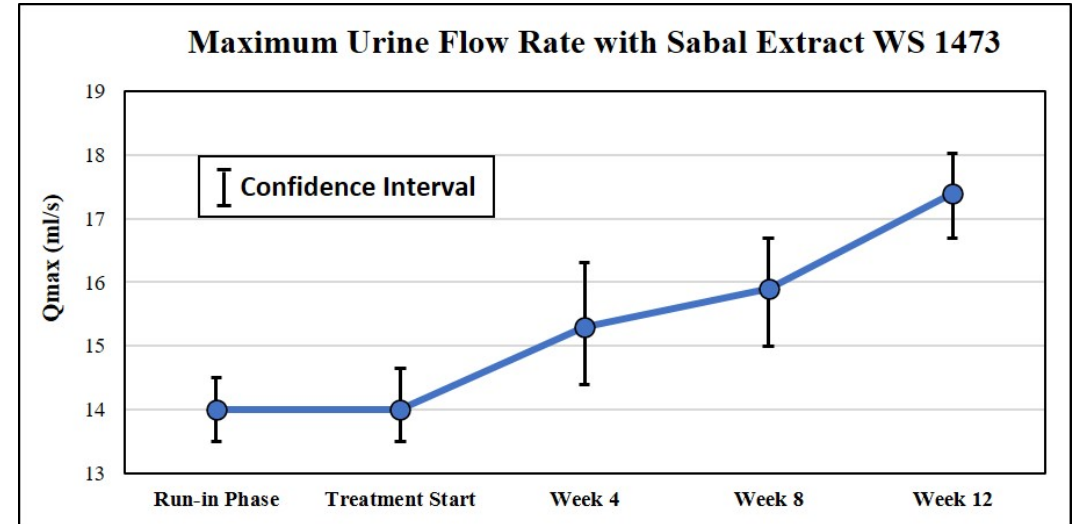
Figure 1. Data on maximum urine flow rate with the ethanolic extract of Serenoa repens (EESr) WS 1473 (Prostagutt Uno ® ) over a 12 wk study. Peak urinary flow rate (Q max , mL/s) mean value curve with a 95% confidence interval reported. Modified based on Redecker et al. [49] .